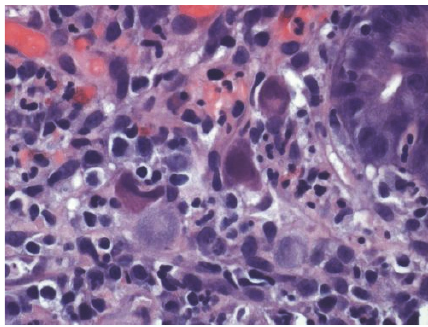
Figure 2: Duodenum biopsy showing CMV cytopathic effect. urinalysis, all within normal limits. Her complete metabolic panel revealed a slightly elevated alanine aminotransferase (ALT) of 48 but normal aspartate aminotransferase (AST).